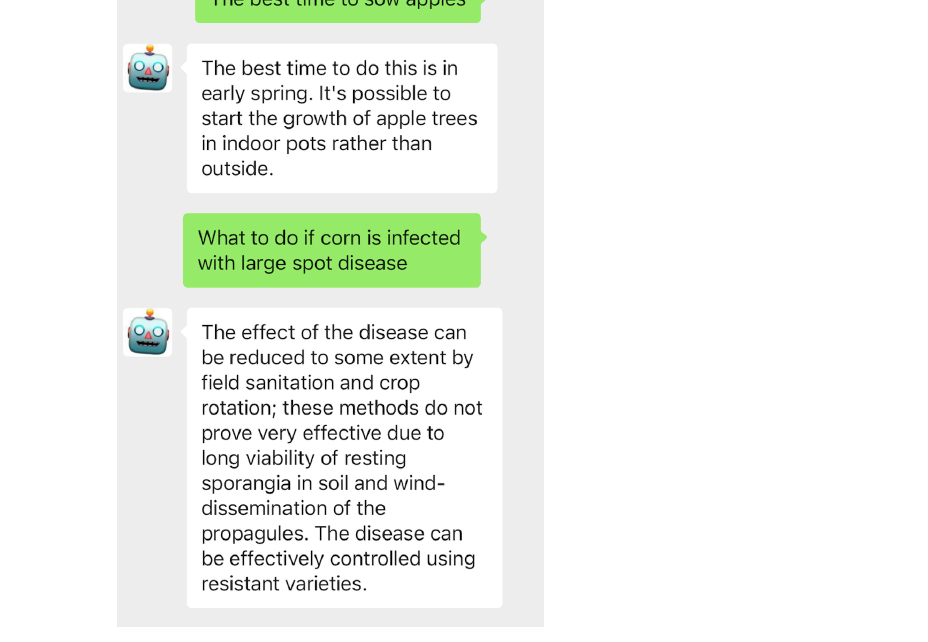
Figure 10. Screenshot of automatic question-and-answering in agricultural scenarios based on the wechat